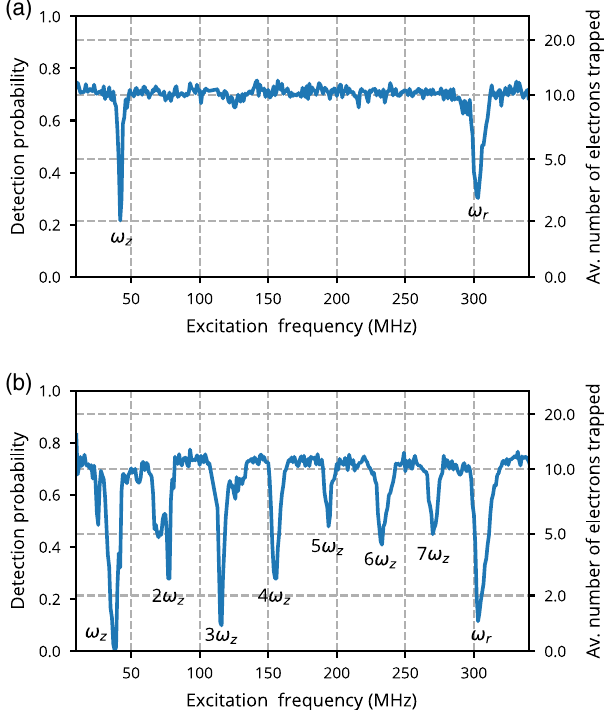
FIG. 6. Trap frequencies. Measurements of the motional resonances for an average of ten electrons loaded into the trap, ¼ 2 ms during which a rf tickle is switched and a wait time t wait on. The axial (radial) resonance is denoted ω z ( ω r ). (a) The 5-mV tickle excitation; (b) 20-mV tickle